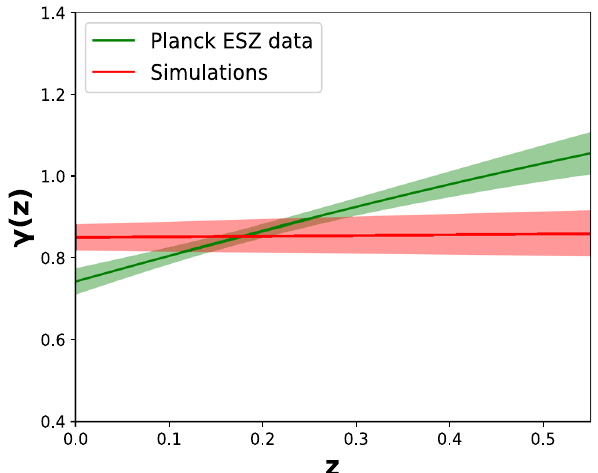
Fig. 4 Reconstructed γ( z ) as a function of z . The green line represents the best GP reconstructed fit for the Planck ESZ data along with the 1 σ error band(shown by green shaded region). The red region shows the NR simulation results at R 500 from [21] by assuming the Eq. (1)